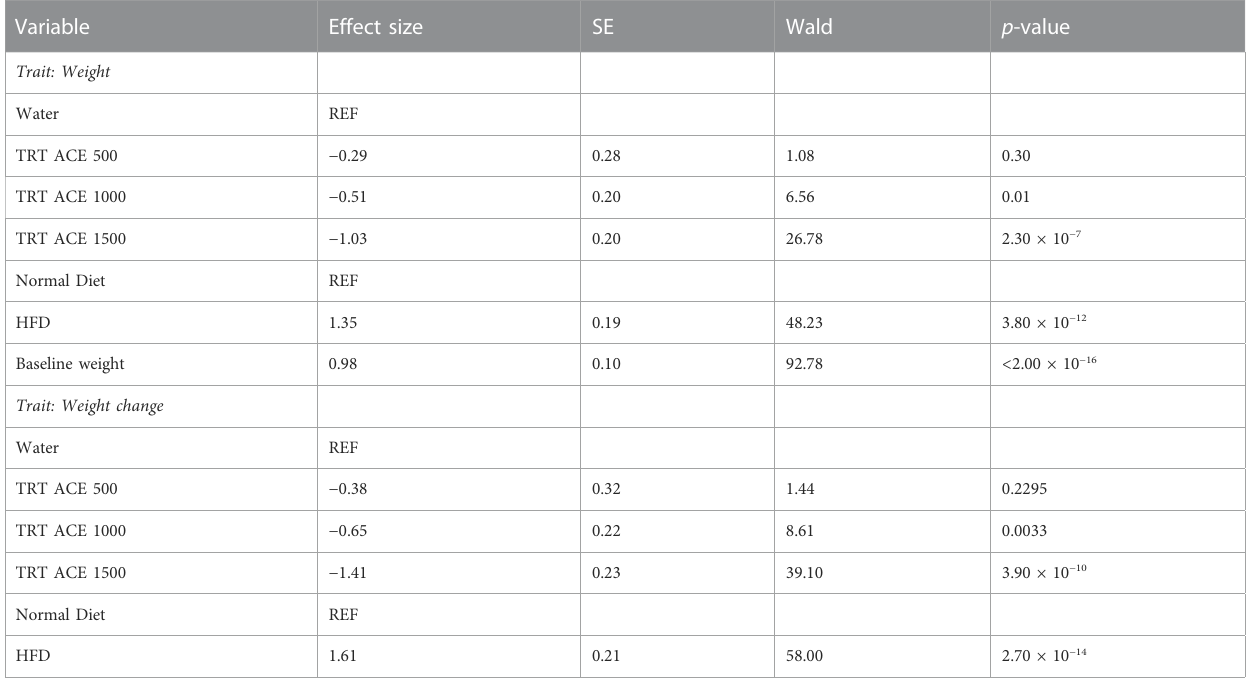
TABLE 3 Results of GEE models for the associations of acetylglycine on mouse weight and weight change.